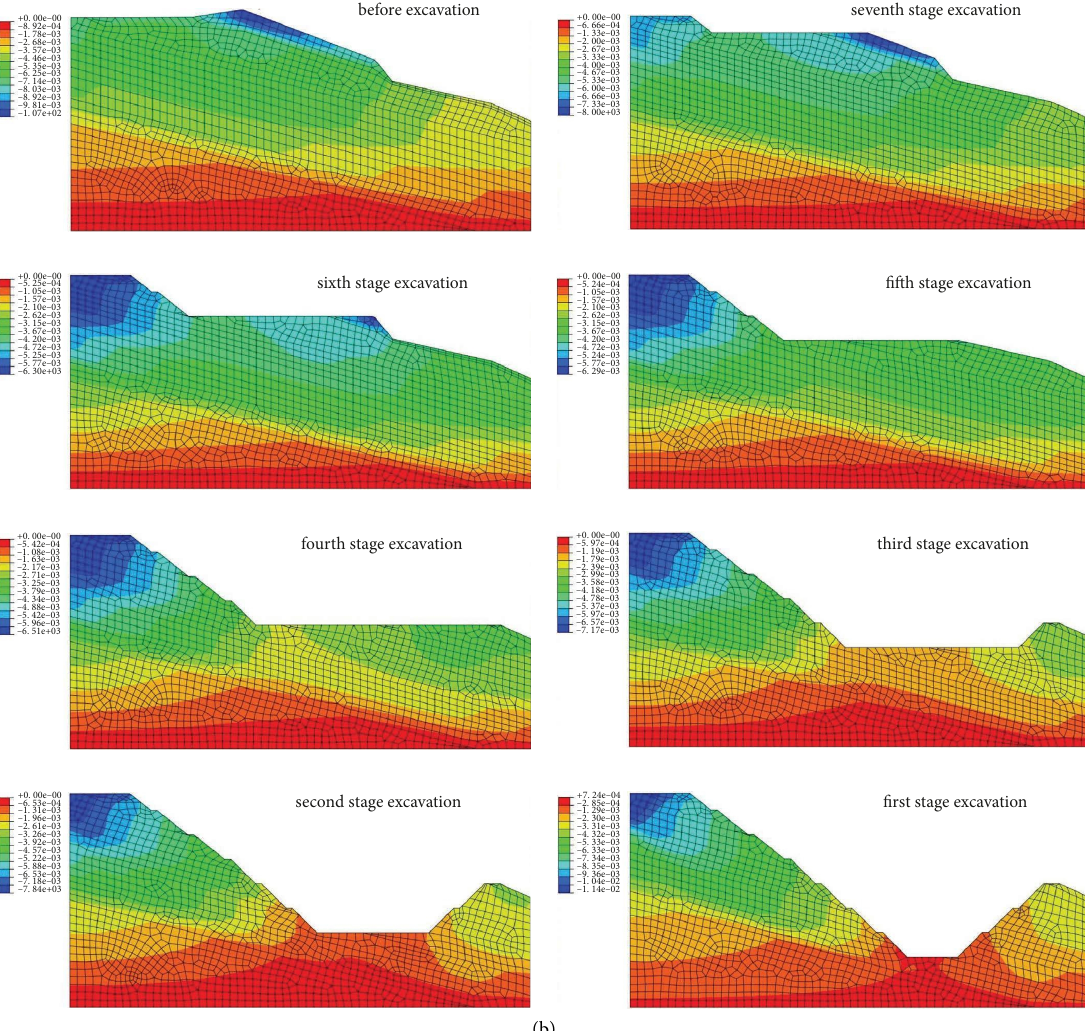
Figure 6: (a) Horizontal displacement and (b) vertical displacement cloud